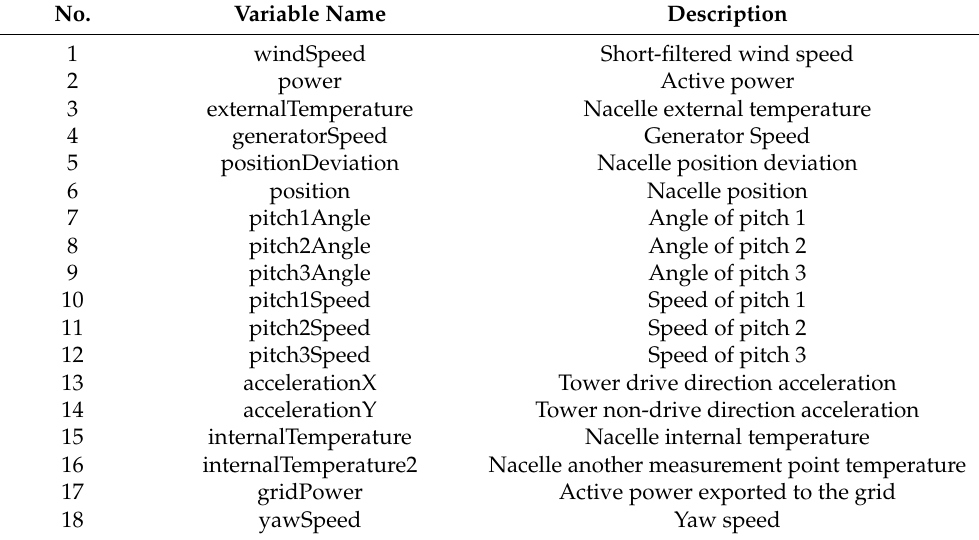
Table 1. Original feature description of the